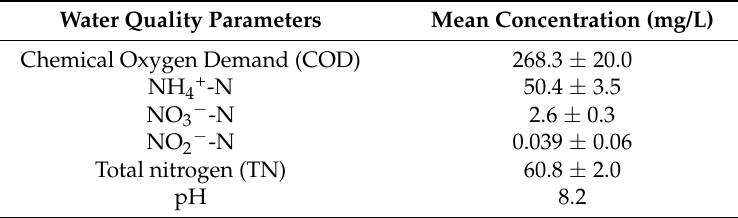
Table 1. Water quality parameters of influent of the first stage.